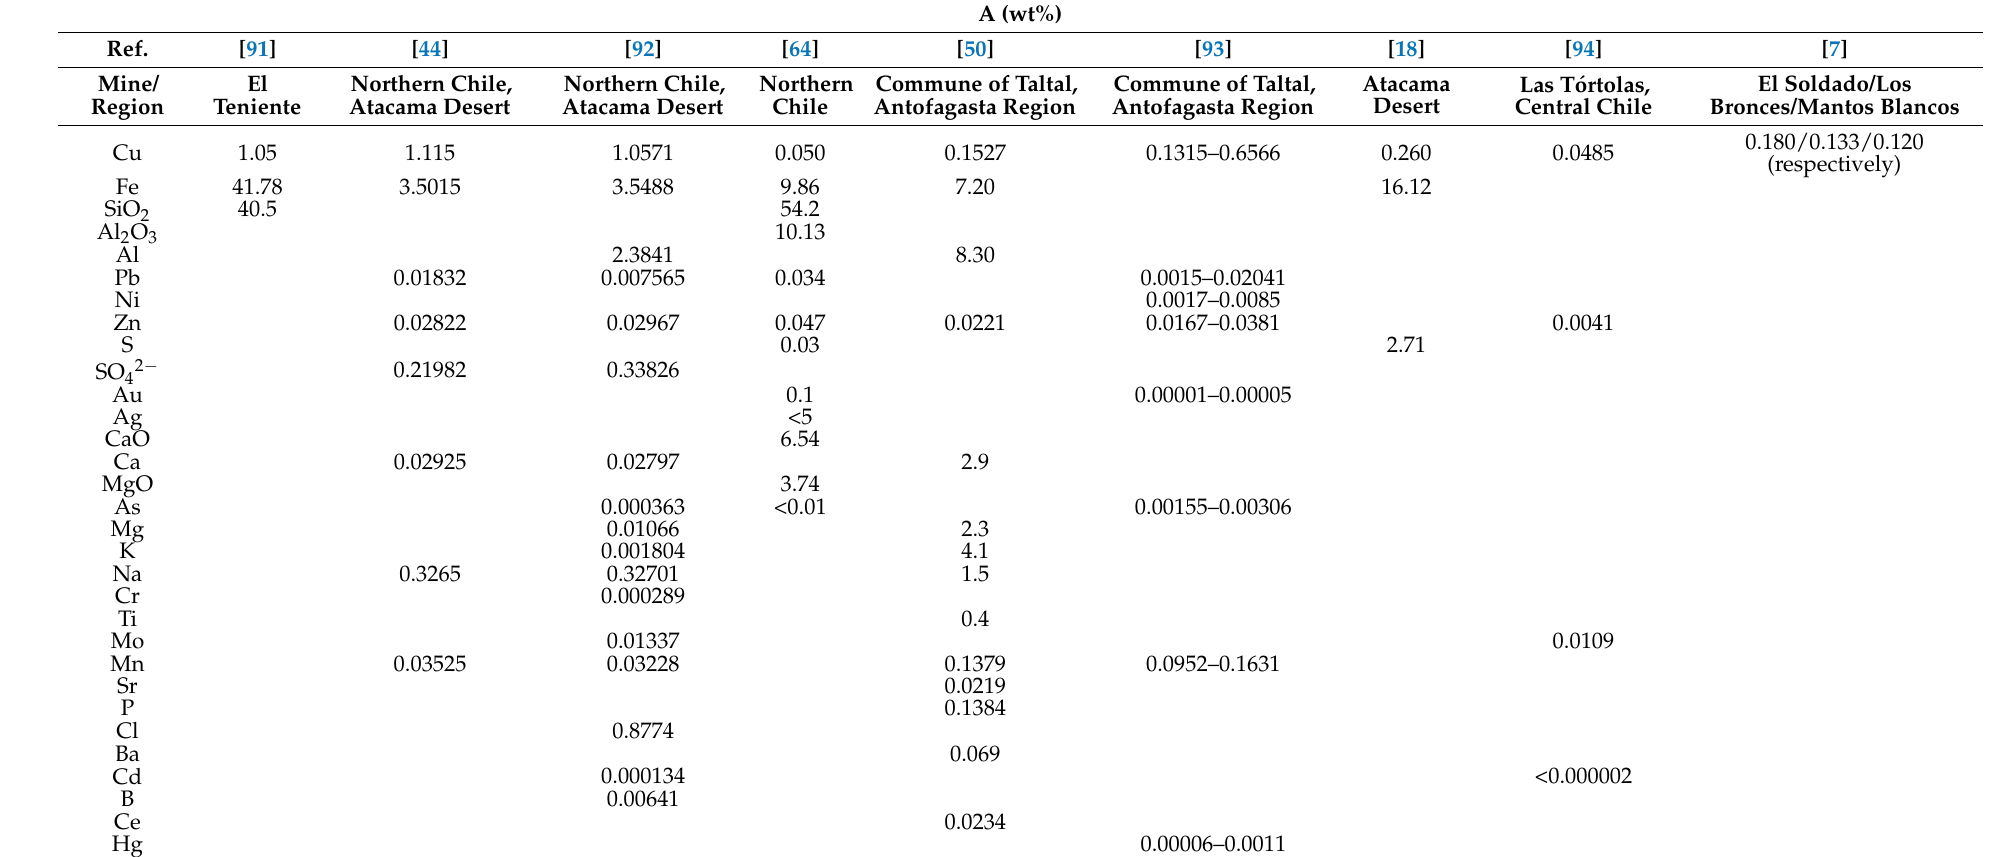
Table 6. Chemical composition of Chilean flotation tailings from copper